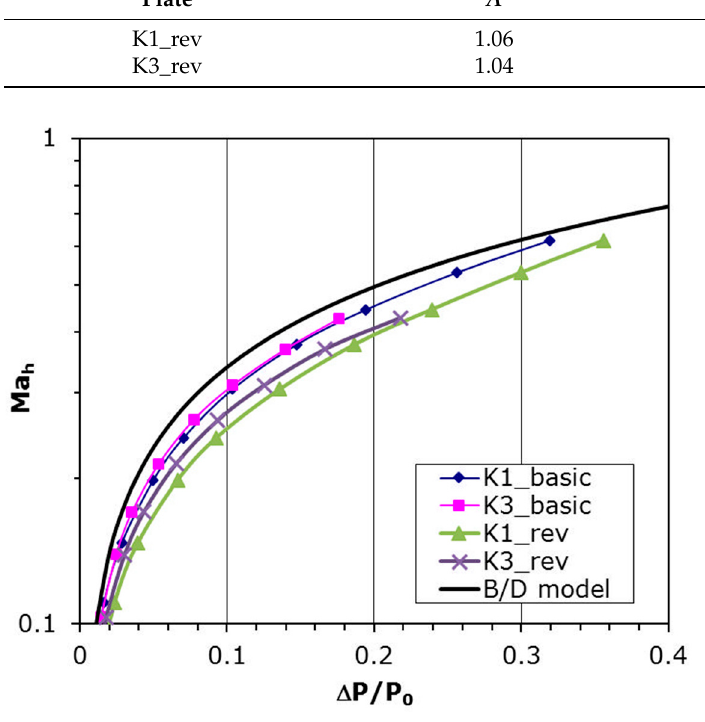
Figure 9. Comparison with B/D model for both plate settings and Plates K1, and K3.